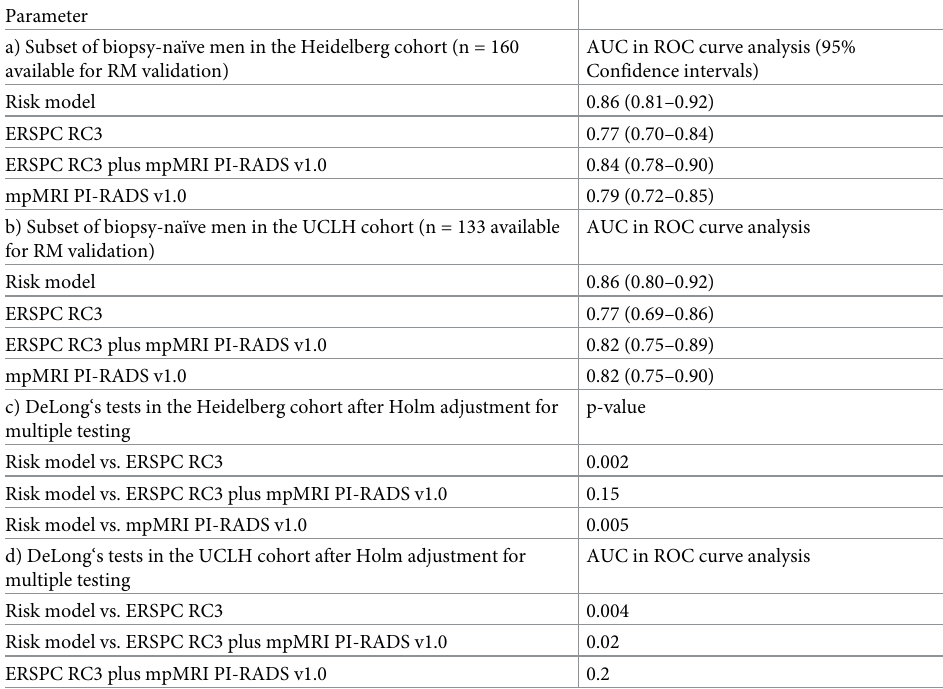
Table 3. Areas under the curve (AUC) of ROC curve analysis for the performance of mpMRI PI-RADSv1.0, ERSPC-RC3, the combination of ERSPC-RC3 and mpMRI PI-RADSv1.0 and the RM to predict sPC for a) Heidel- berg validation cohort, and b) for men in the UCLH